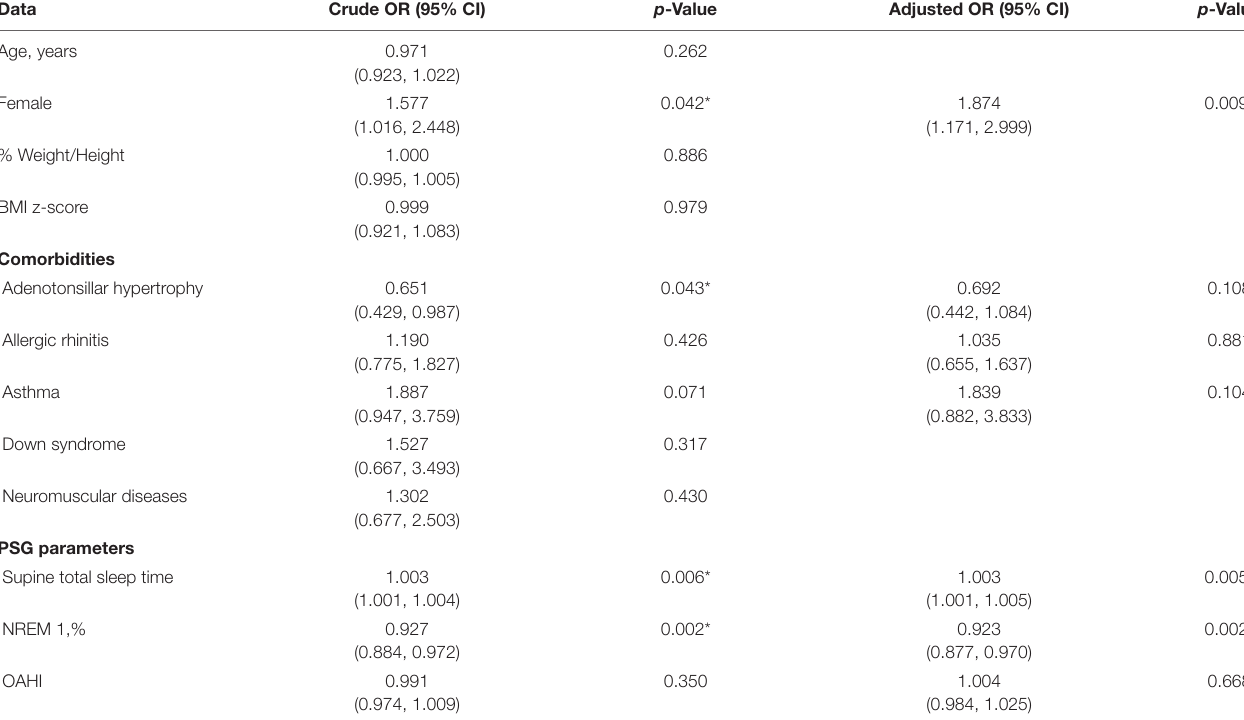
TABLE 5 | Odd ratio, 95% confidence interval and p -value of REM-related OSA and other subtypes for demographic data, comorbidity, consequence, and polysomnographic